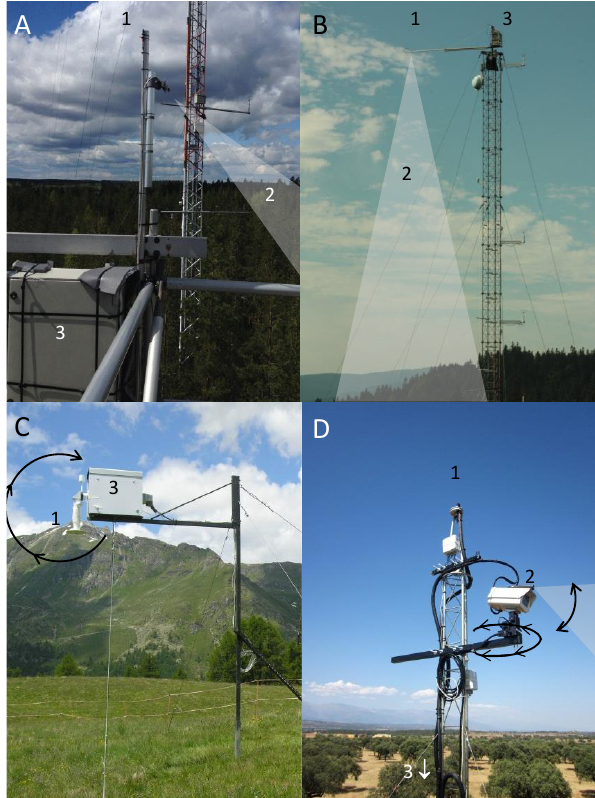
Figure 4. Hyperspectral systems in use before and during EU- ROSPEC. The UNIEDI system (a) , the S-FLUOR/MRI system (b) , the HSI System in which both the up- and down-welling measure- ments are hemispherical (c) and the AMSPEC-MED system where the spectrometer measuring up-welling radiance can measure at multiple zenithal and azimuthal angles (d) . Down-welling hemi- spherical foreoptics (1), up-welling conical-FOV foreoptics (2) and the box housing the spectrometers (3) are marked in the respective